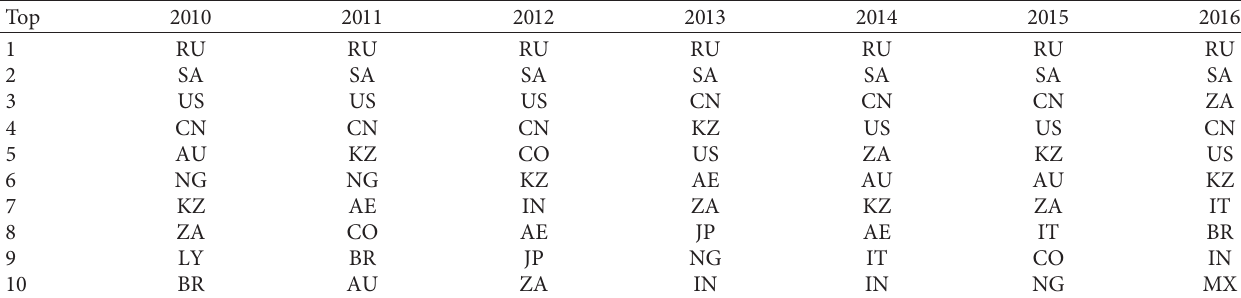
Table 3: The variance of the top 10 countries with node degrees in minimum spanning trees of crude oil trade before optimization during 2010 and 2016. The light gray spaces represent the major crude oil exporting countries (see Table 5 for the countries in the selected sample). Top